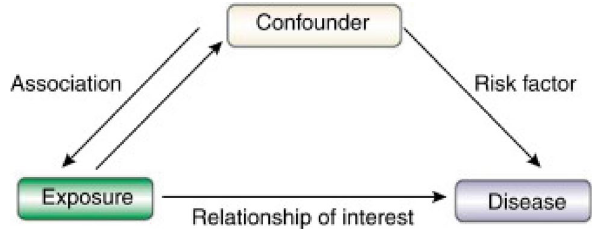
Fig. 1 The structure of confounding. Source: Jager et al.